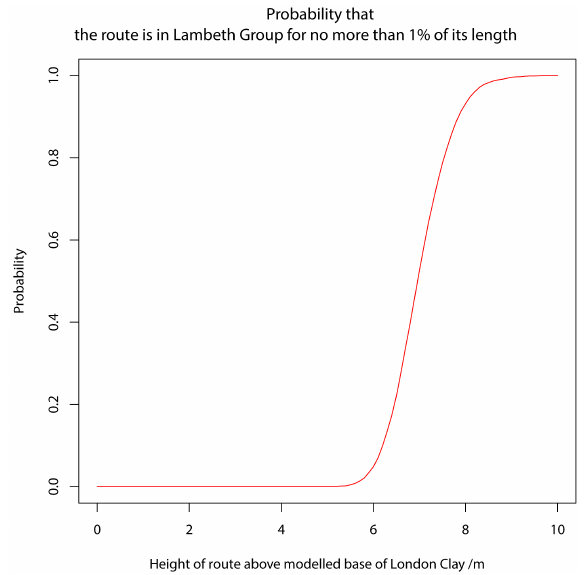
Figure 6. How close to the modelled base of the London Clay could you build a tunnel (over the last 4km of the cross section) and have a specified probability (ordinate) that the tunnel will stray into the underlying Lambeth Group for no more than 1% of its